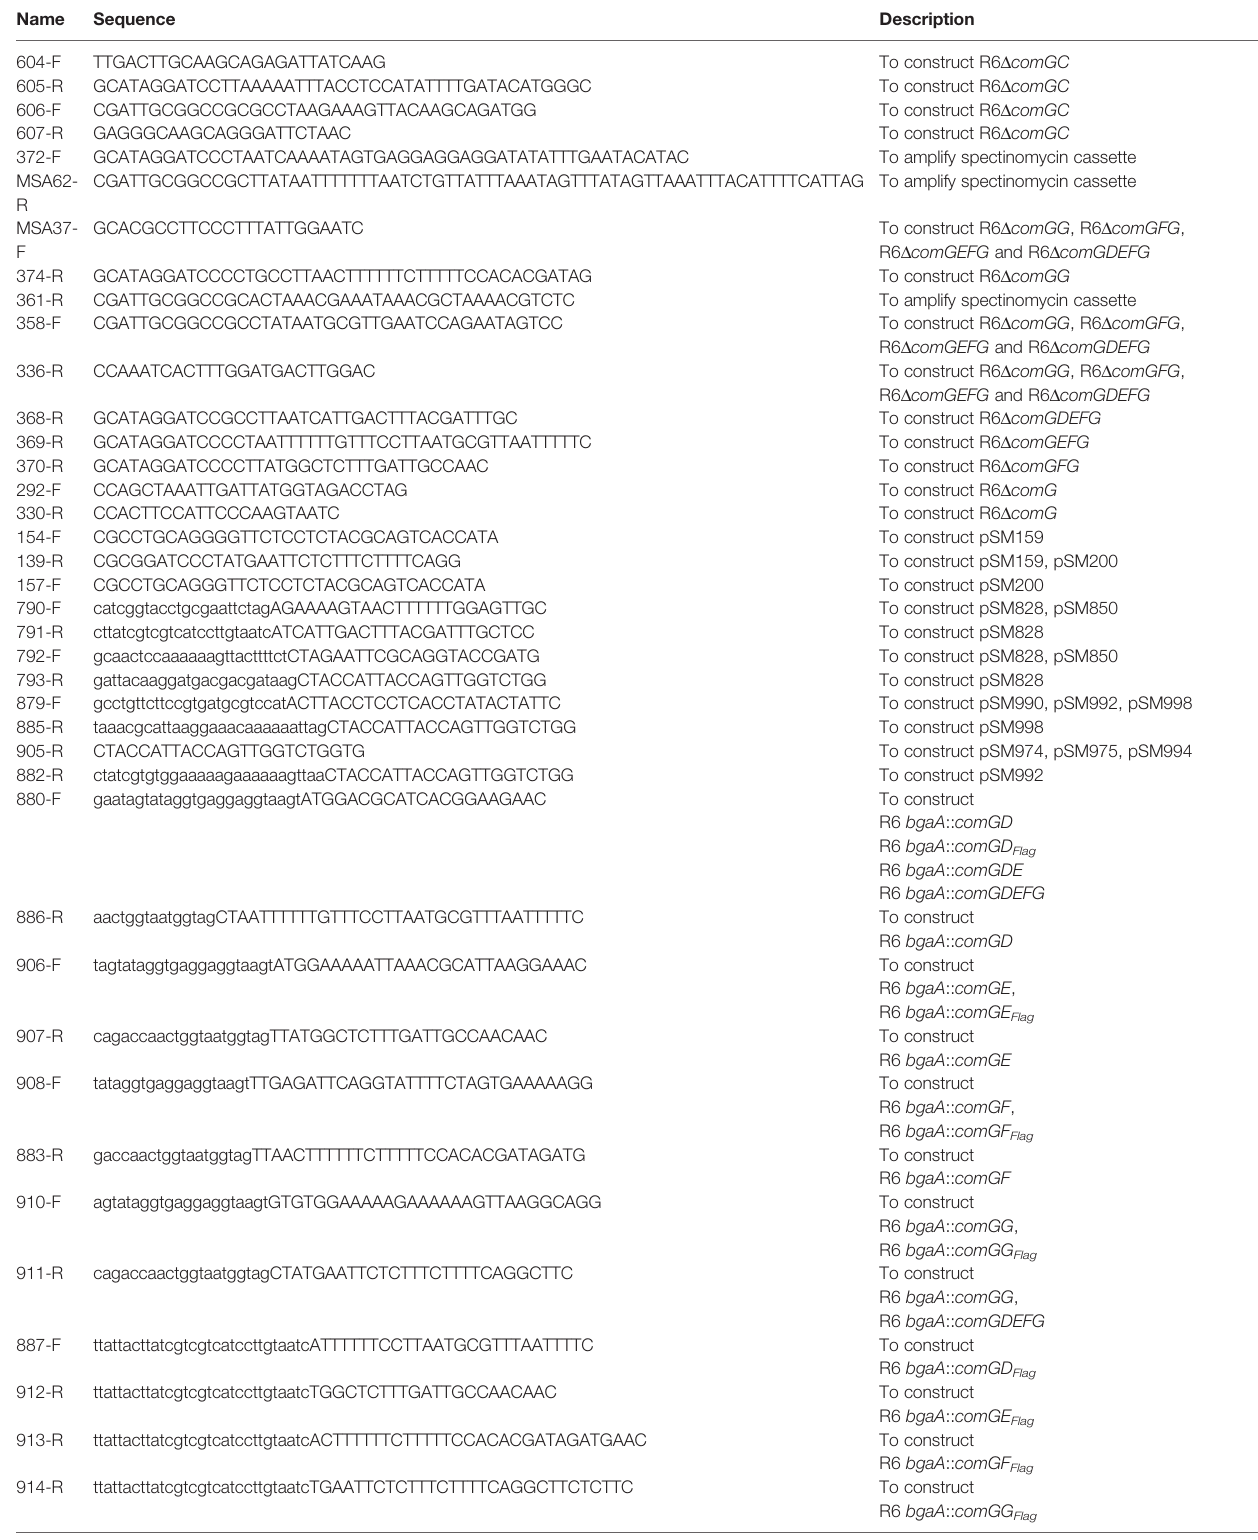
TABLE 2 | Primers used in this